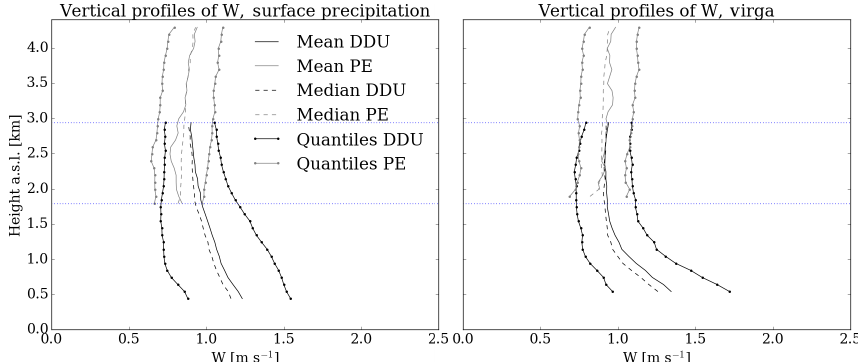
Figure C1. Vertical profile of mean Doppler velocity at DDU (black lines) and PE (grey lines). Solid and dashed lines correspond to mean and median profiles, respectively. Dotted solid lines represent the 20% and 80% quantiles. The curves are equivalent to Figs. 4e, f and 5e, f, but height is expressed in altitude above mean sea level. Horizontal dotted blue lines delimit the common height region of the profiles at both